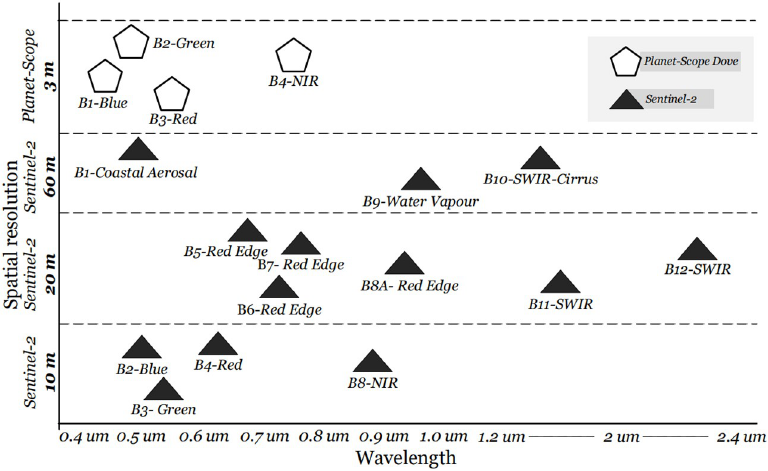
Fig 3. Sentinel-2 and Planet-Scope bands distribution according to EM spectrum and spatial resolution.